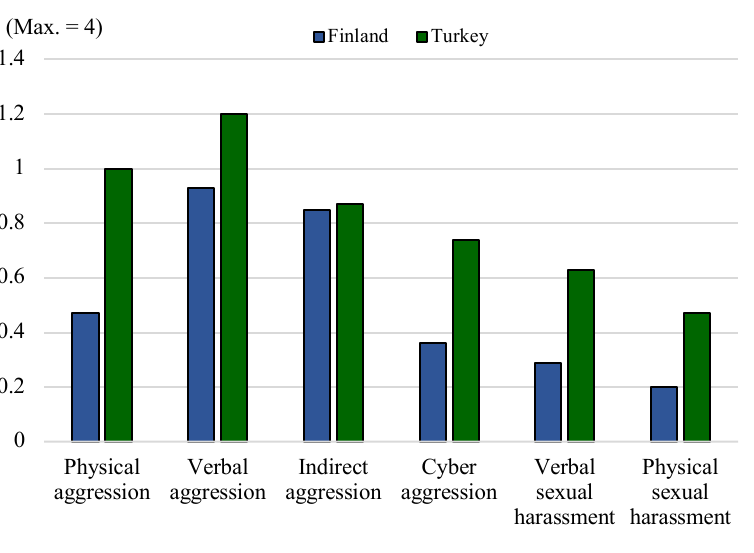
Mean scores for victimization from six types of aggression and sexual harassment, according to country of residence (N = 1,597). For significant differences, cf. Table